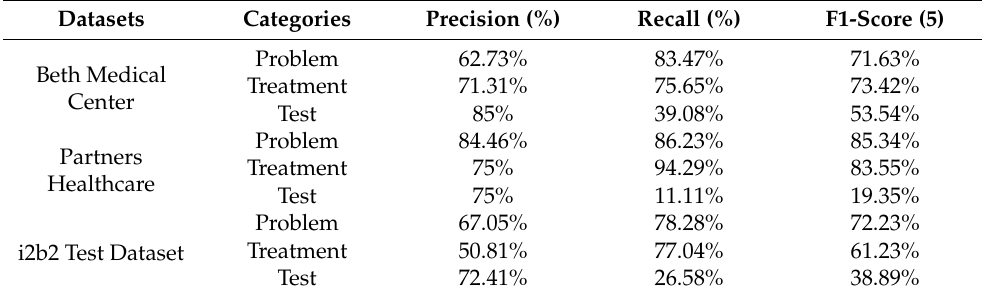
Table A2. Individual concepts’ performance measures for the Beth, Partner, and Test datasets, employing approximate term matching to UMLS.